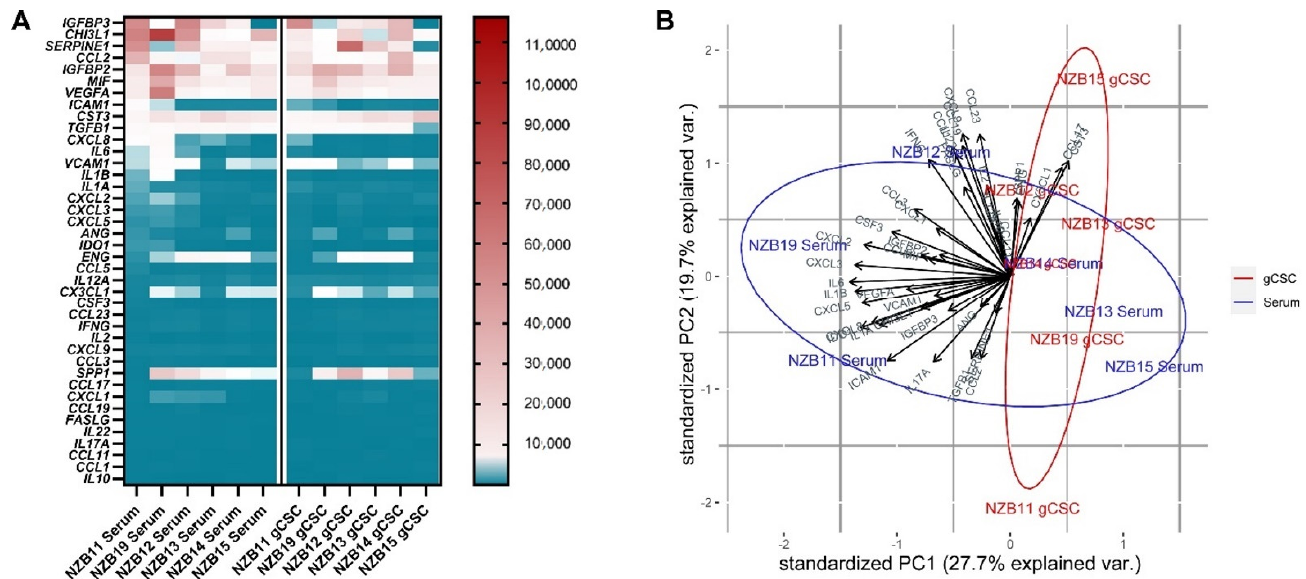
Figure 2. Secreted protein gene expression profiles comparing serum and gCSC glioblastoma cells. ( A ) NanoString median mRNA count in serum-derived and gCSC primary glioblastoma cell lines. ( B ) Principal component analysis of log10 transformed nanoString intensities. The first and second principal components show 27.7% and 19.7%, respectively.